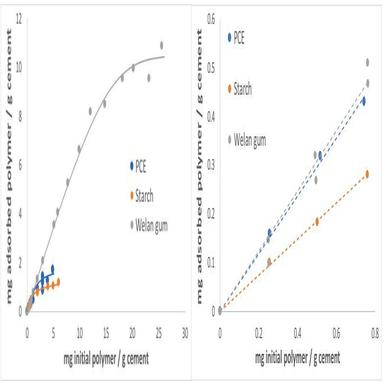
Adsorption isotherms of PCEs and starch-based and welan gum VMAs. Reproduced from with permission.